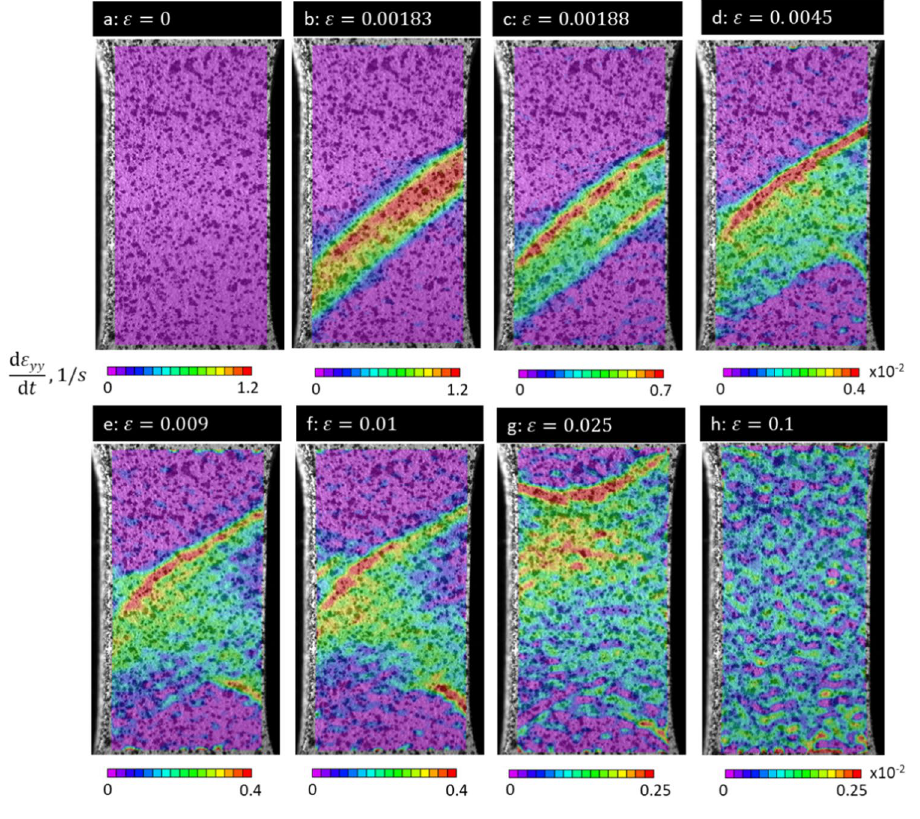
Figure 3. DIC strain rate fields (dε yy /dt) illustrating the development of plastic instabilities from ( a ) ε = 0 to ( b ) ε = 0.00183, ( c ) ε = 0.00188, ( d ) ε = 0.0045, ( e ) ε = 0.009, ( f ) ε = 0.01, ( g ) ε = 0.025, and ( h ) ε = 0.1.